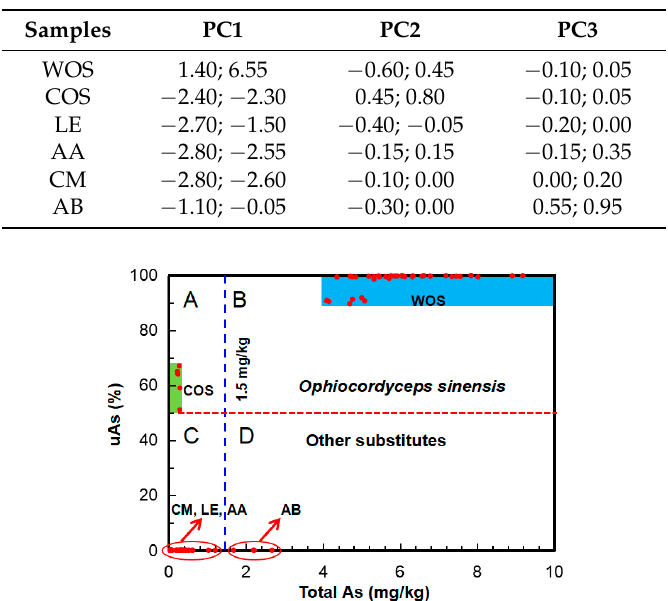
Figure 6. uAs (%) vs. tAs (mg/kg) plot illustrating the fields of wild O. sinensis [blue in field ( B )], cultivated O. sinensis [green in field ( A )], and the other mushrooms. Red dashed line divides the samples into the groups of O. sinensis (WOS and COS) and the groups of the other mushrooms (CM, AB, LE, and AA). Blue dashed line divides the samples into the groups of wild (WOS and AB) and cultivated (COS, CM, LE, and AA) mushrooms.